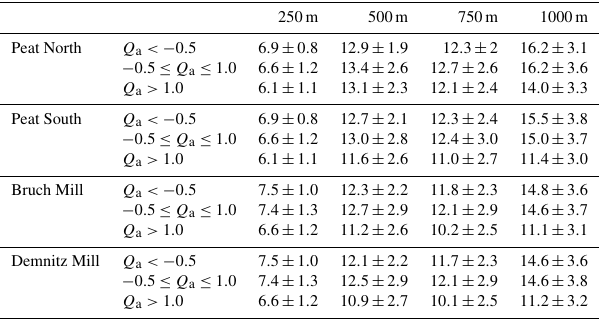
Table 6. Estimated stream water ages (years) under high-flow anomaly ( Q a > 1 . 0), normal flows ( − 0 . 5 ≤ Q a ≤ 1 . 0), and below- average-flow anomaly ( Q a ≤ − 0 . 5) for Peat North, Peat South, Bruch Mill, and Demnitz Mill. 250m 500m 750m 1000m Peat North Q a < − 0 .